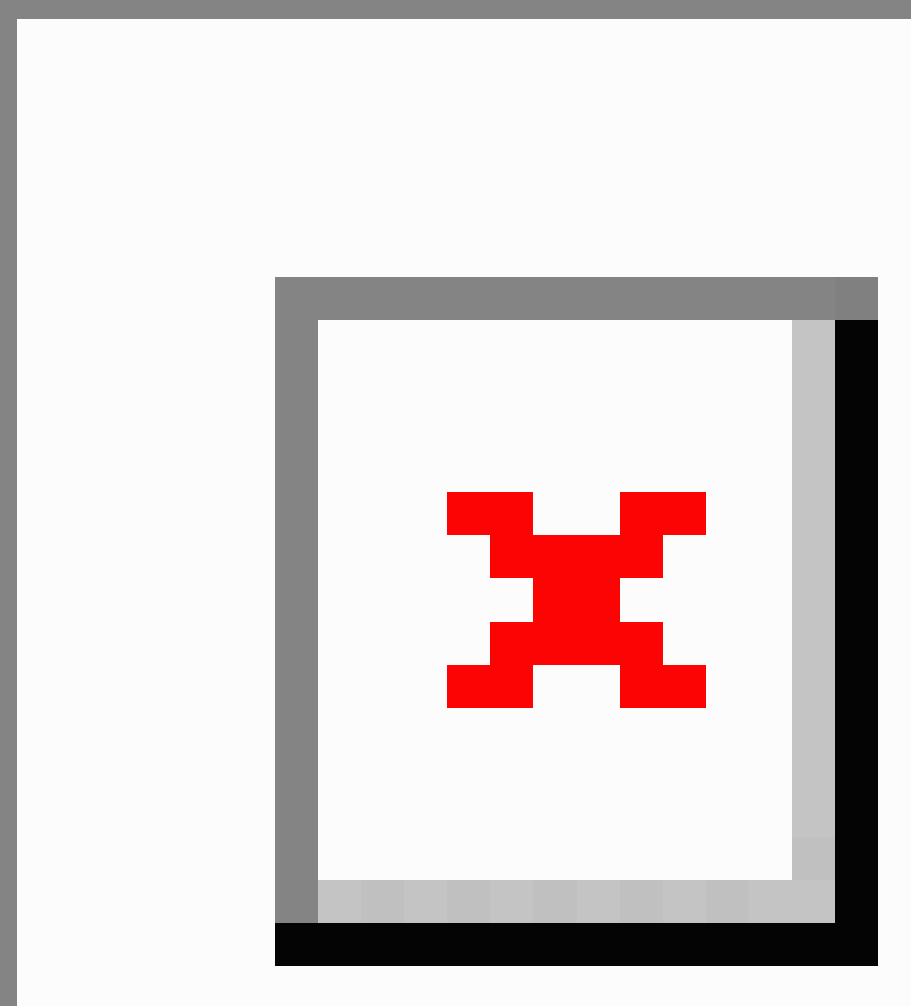
Figure 2. Screenshot of a recipe from "@TheTable" cookbook